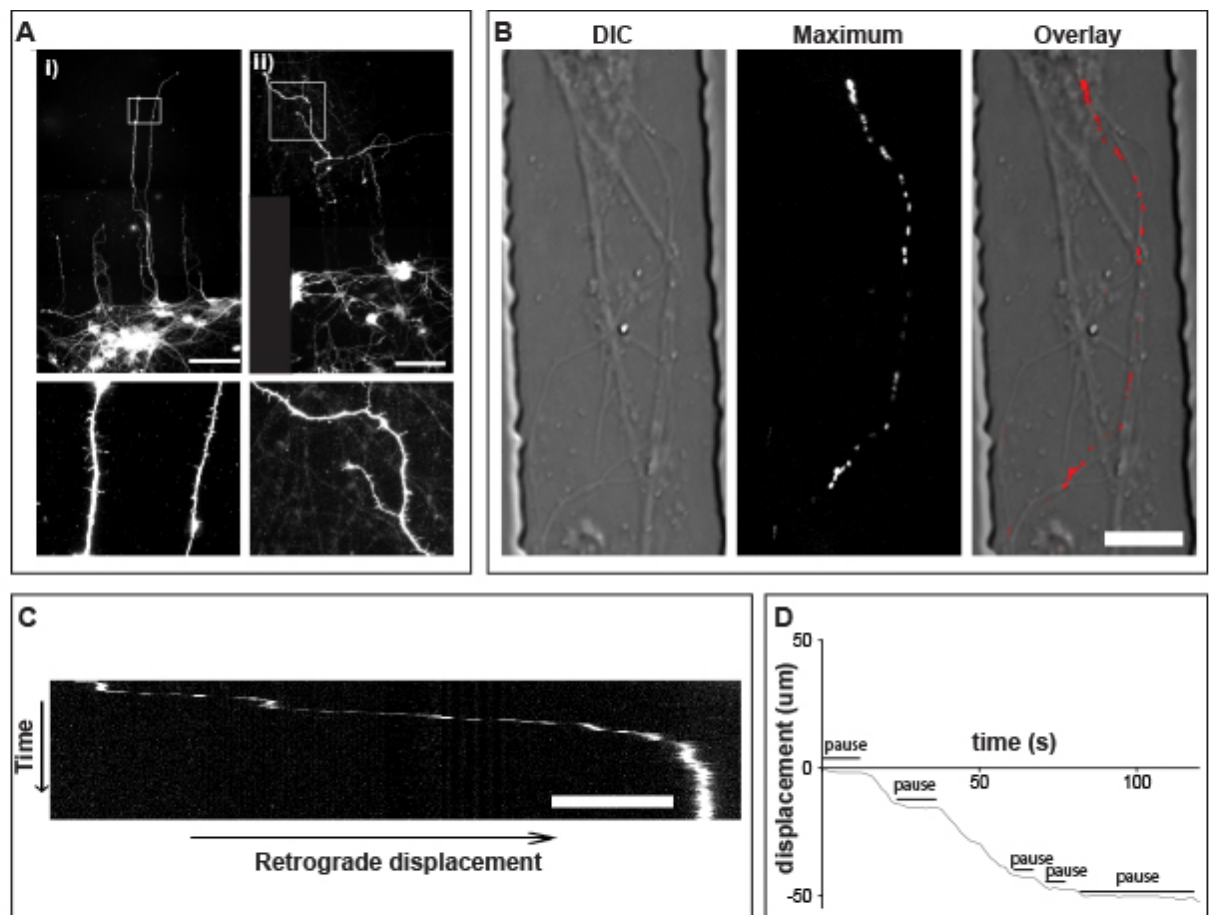
Figure 4. Prolonged pauses dominate the QD-BDNF transport in MSN dendrites. ( A ).(i) Map 2 shows immunofluorescence of dendrites in striatal neuron culture crossing short microgrooves. Bottom inset from (i) highlights dendritic spines. (ii) DARPP-32 immunofluorescence, showing medium spiny neurons in culture. Bottom inset from (ii) shows MSN dendritic spines stained with DARPP-32. ( B ). High-power (100×) images of dendrites in the short microgrooves. Differential interference contrast (DIC), maximum projection of QD-BDNF retrograde transport and color overlay from Movie 2. ( C ). Kymograph of QD-BDNF dendrite transport from Movie 2. ( D ) displacement vs. time plot of QD-BDNF dendrite transport from Movie 2. Scale bars = 20 µm ( A ), 5 µm ( B , C ).